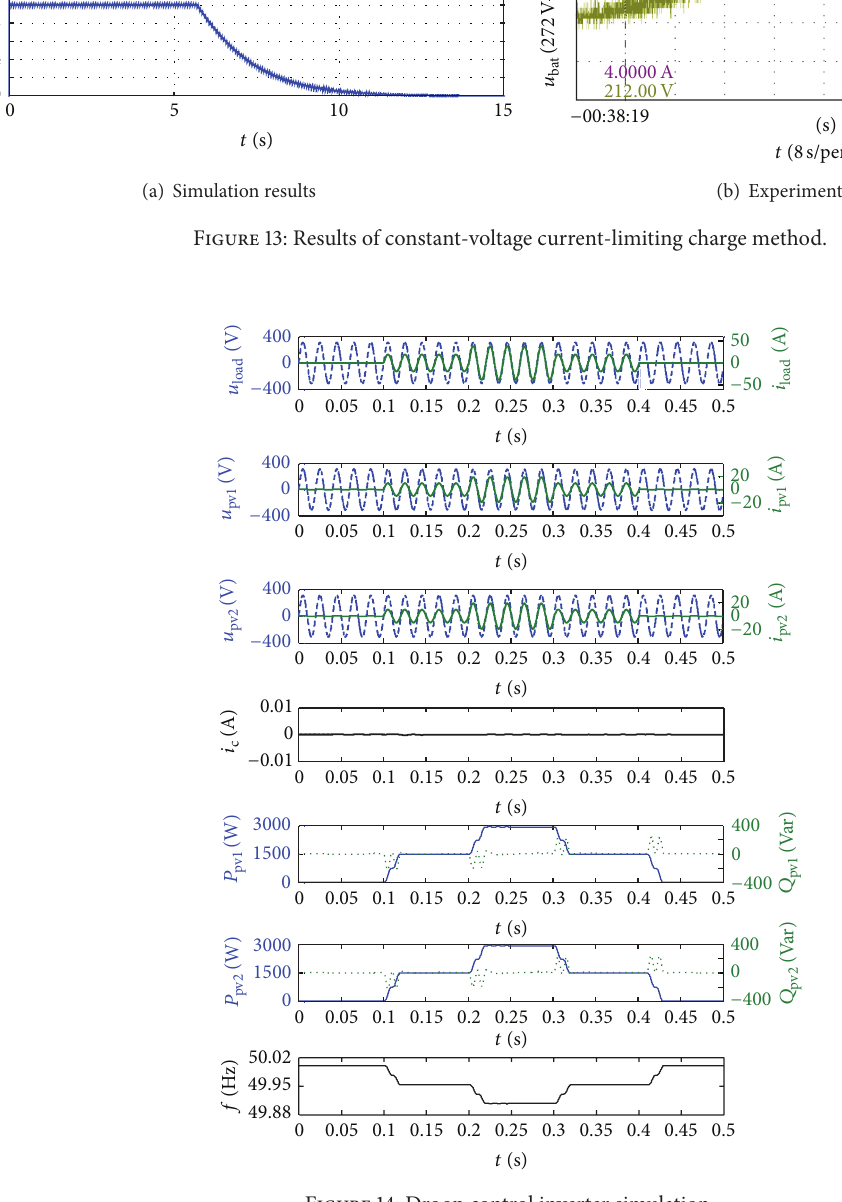
Figure 14: Droop control inverter